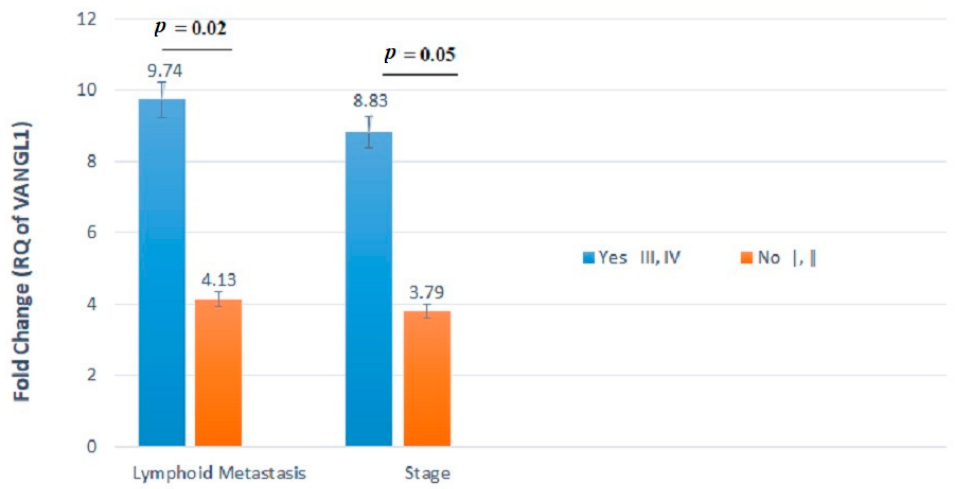
Figure 1. VANGL1 mRNA relative quantification (RQ) established by RT-qPCR analysis according to lymph node metastasis (LNMs) involvement or stage. Gene expression levels of VANGL1 differed significantly between patients with and without LNMs.